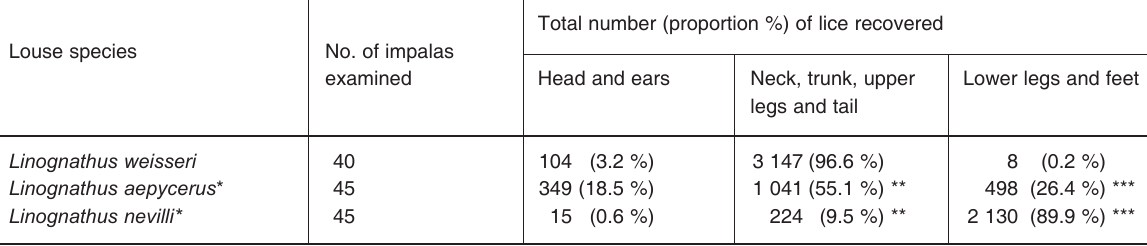
Total number (proportion %) of lice recovered